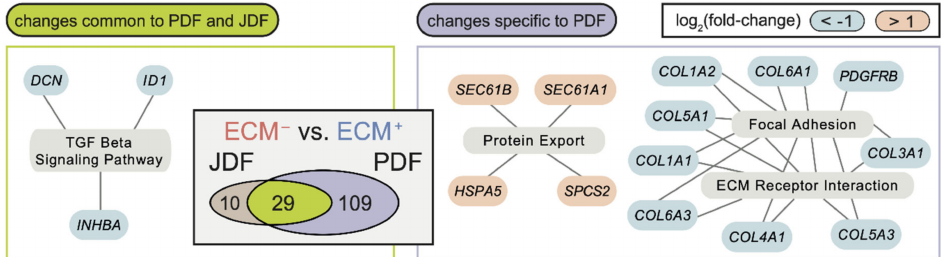
Figure 4. The di ff erences between the ECM − and ID + fibroblast clusters are largely replicated in PDF and JDF spheroids with distinct features present in PDF fibroblasts. Changes common to both samples (left) are enriched in genes downregulated in ECM − clusters and participating in several KEGG pathways related to extracellular matrix and TGF- β signalling. Changes specific to PDF spheroids (right) include hyperactivation of genes participating in cytokine signalling in the ECM − cluster. No KEGG pathway enrichment specific to the JDF sample was observed. The Venn diagram (inset) displays a significant overlap ( p < 10 − 6 , Fisher’s exact test) of di ff erentially expressed genes (false discovery rate FDR < 0.05, at least two-fold change in gene expression) in the comparison of the ECM − and ID + fibroblast clusters in JDF and PDF